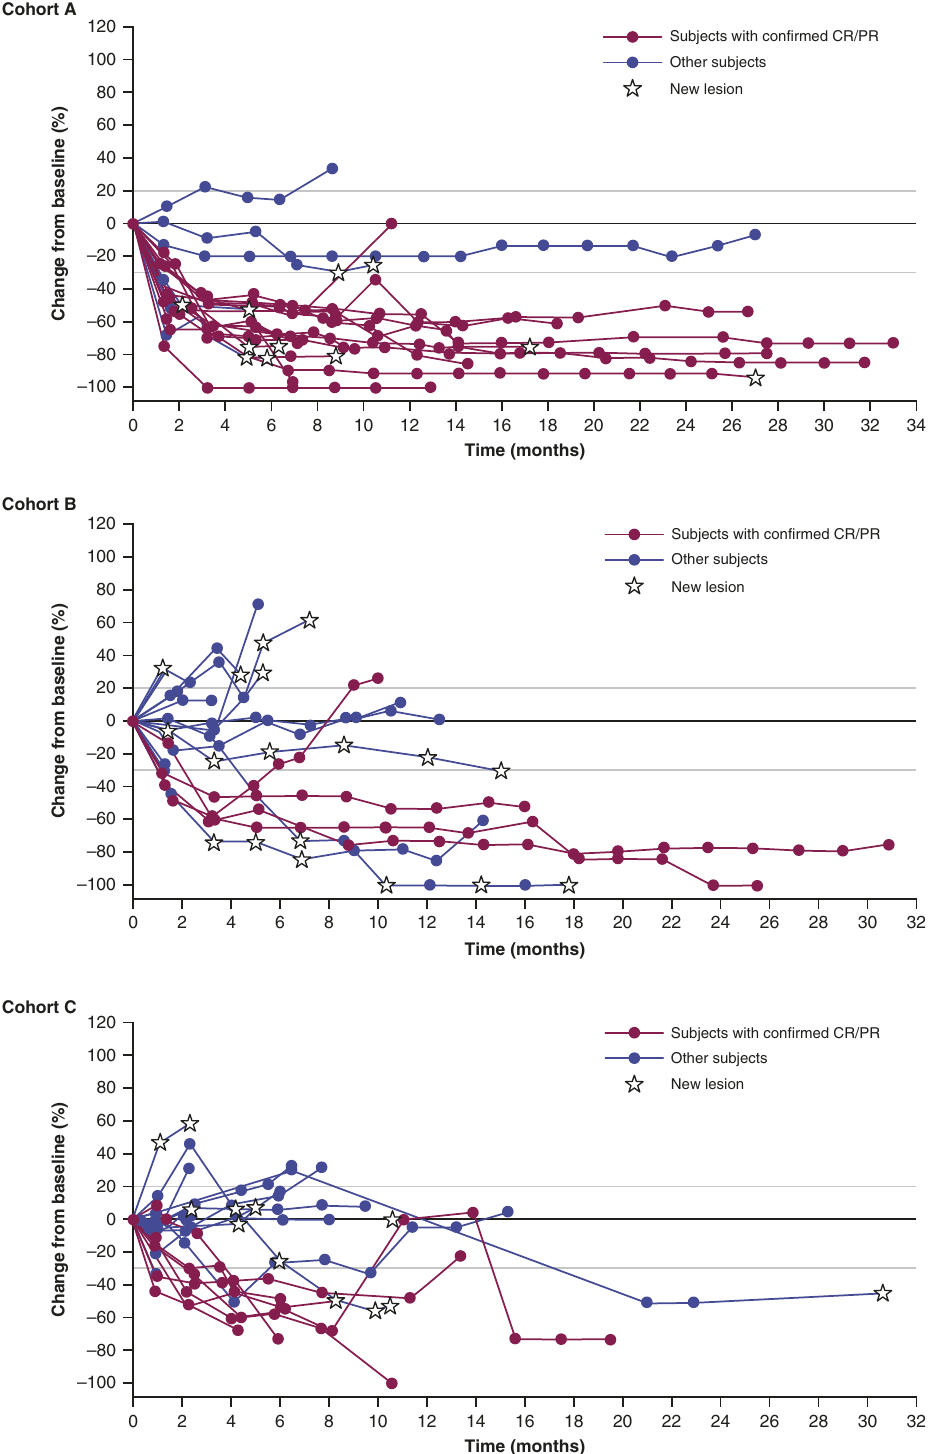
Fig. 1 Best percentage change from baseline in tumor diameter (as-treated population). Longitudinal tumor size was analyzed using a non-linear mixed- effects model to determine tumor growth rate constants and time to growth. Cohort A, n = 26; Cohort B, n = 20; Cohort C, n = 22. CR/PR, complete response/partial RNA-sequenced gene expression pro fi ling was performed on and 1 not evaluated), 16 patients in cohort B (including 3 with 95 biopsies from 65 patients; of these, 84 samples had adequate PRs, 11 with SD, and 2 with disease progression), and 14 quality for analysis (Supplementary Fig. 3, Supplementary patients in cohort C (including 4 with PRs, 4 with SD, 3 with Table 2). The analyzed biopsies were from 20 patients in cohort A disease progression, and 3 not evaluated) (Fig. 3, Supplementary (including 13 with CRs or PRs, 6 with stable disease [SD], Fig. 4).